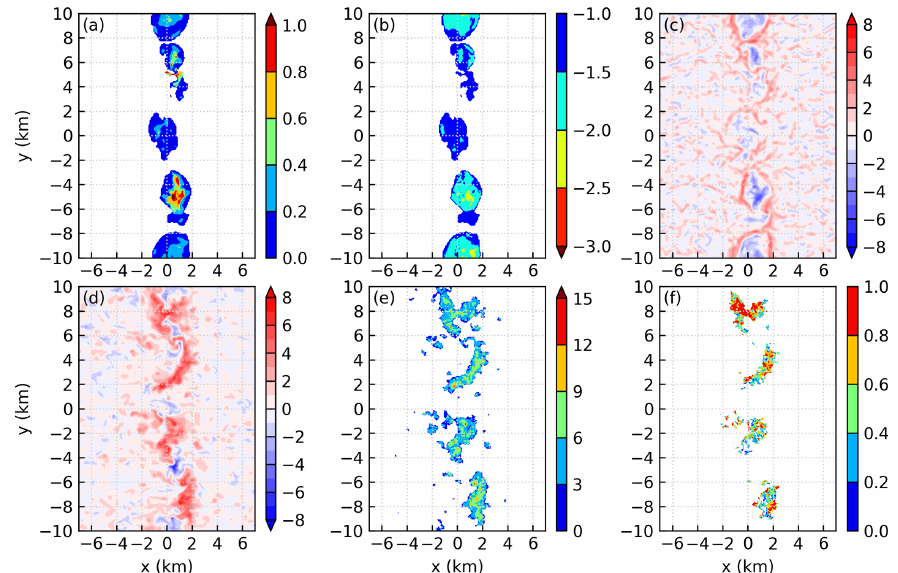
Figure 11. Panels (a) and (b) are, respectively, the depth (km) and temperature surplus (K) of the cold pools. Panels (c) and (d) are, respectively, the vertical velocity at z = 0 . 2 and 0.88km. (e) The number of parcels that are lifted at each grid point. (f) The fraction of parcels that rise above 6km in all parcels that are lifted. The parcels are released at t = 7h 55min and tracked forward for 25min. The results are at t = 8h of simulation